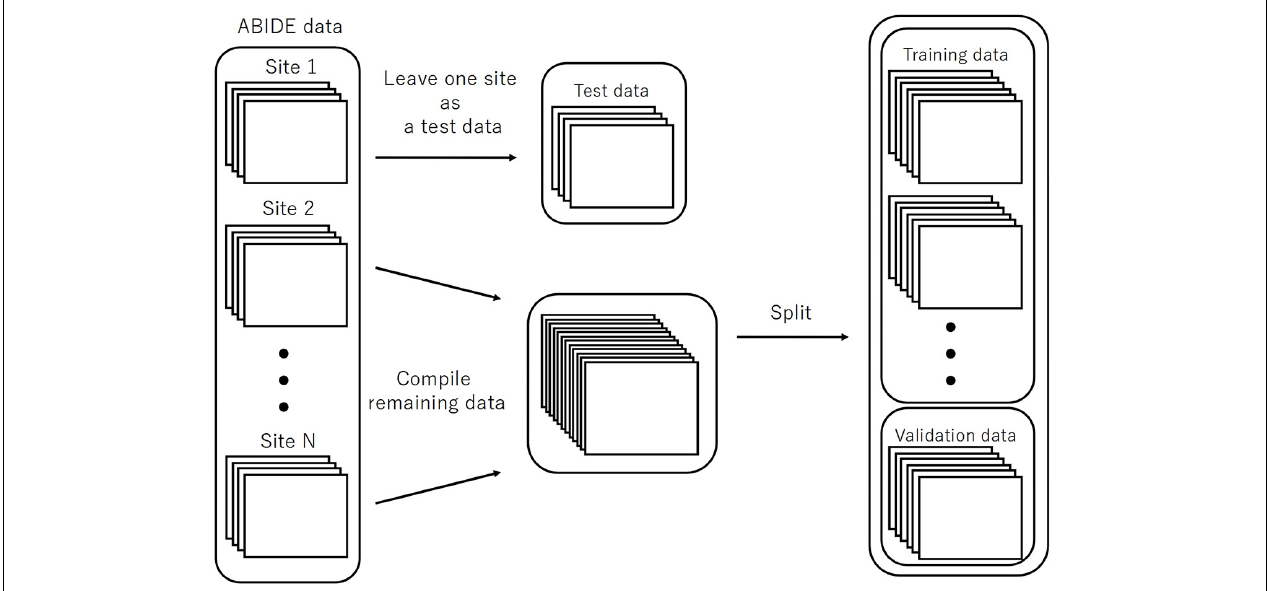
FIGURE 3 | The splitting method for the evaluation of LOSO-CV accuracy. LOSO-CV, leave-one-site-out